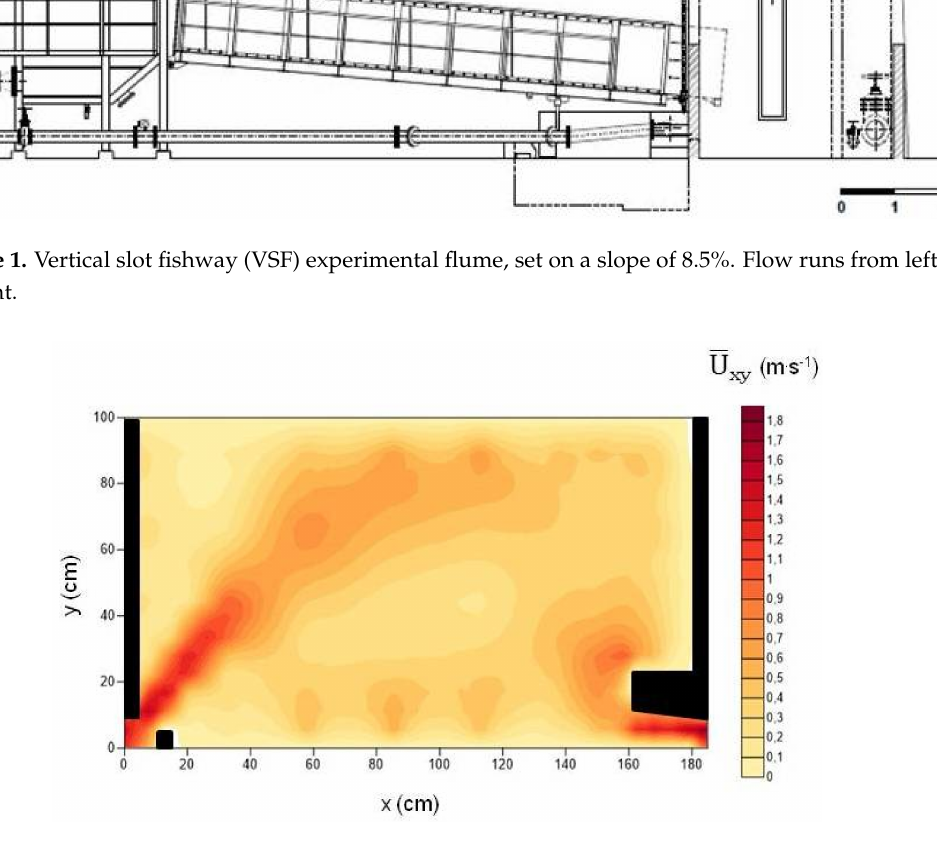
Figure 2. Horizontal mean water flow velocity U xy (m · s − 1 ) contour lines at a water depth of 0.50 m. A ADV (Acoustic Doppler Velocimeter) was used to measure the instantaneous velocity components (x and y). Flow enters at the bottom left corner and exits at the bottom right